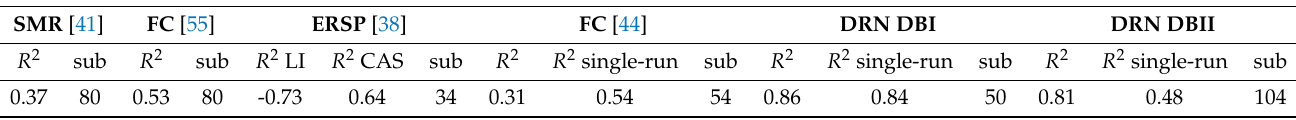
Table 7. Performance comparison with works recently presented that employ correlates between accuracy and sensorimotor rhythms (SMR) or FC indicators. S denotes the number of subjects in respective